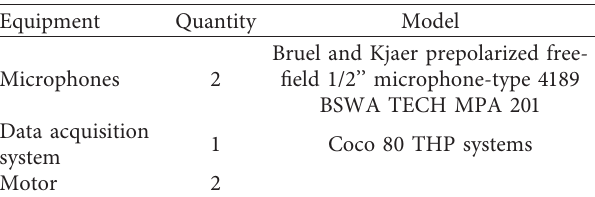
Figure 11: Positions of sensors used for the experimental Table 2: Equipment used in the experiment.